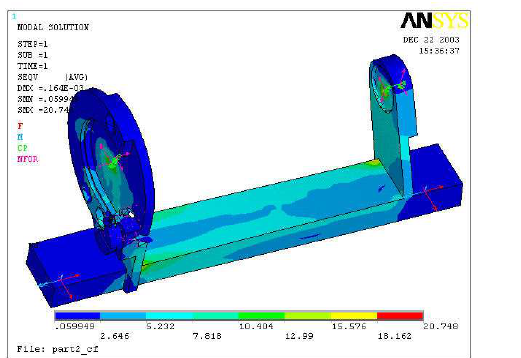
Fig. 12. Strength Analysis of Subassembly ‘B’.